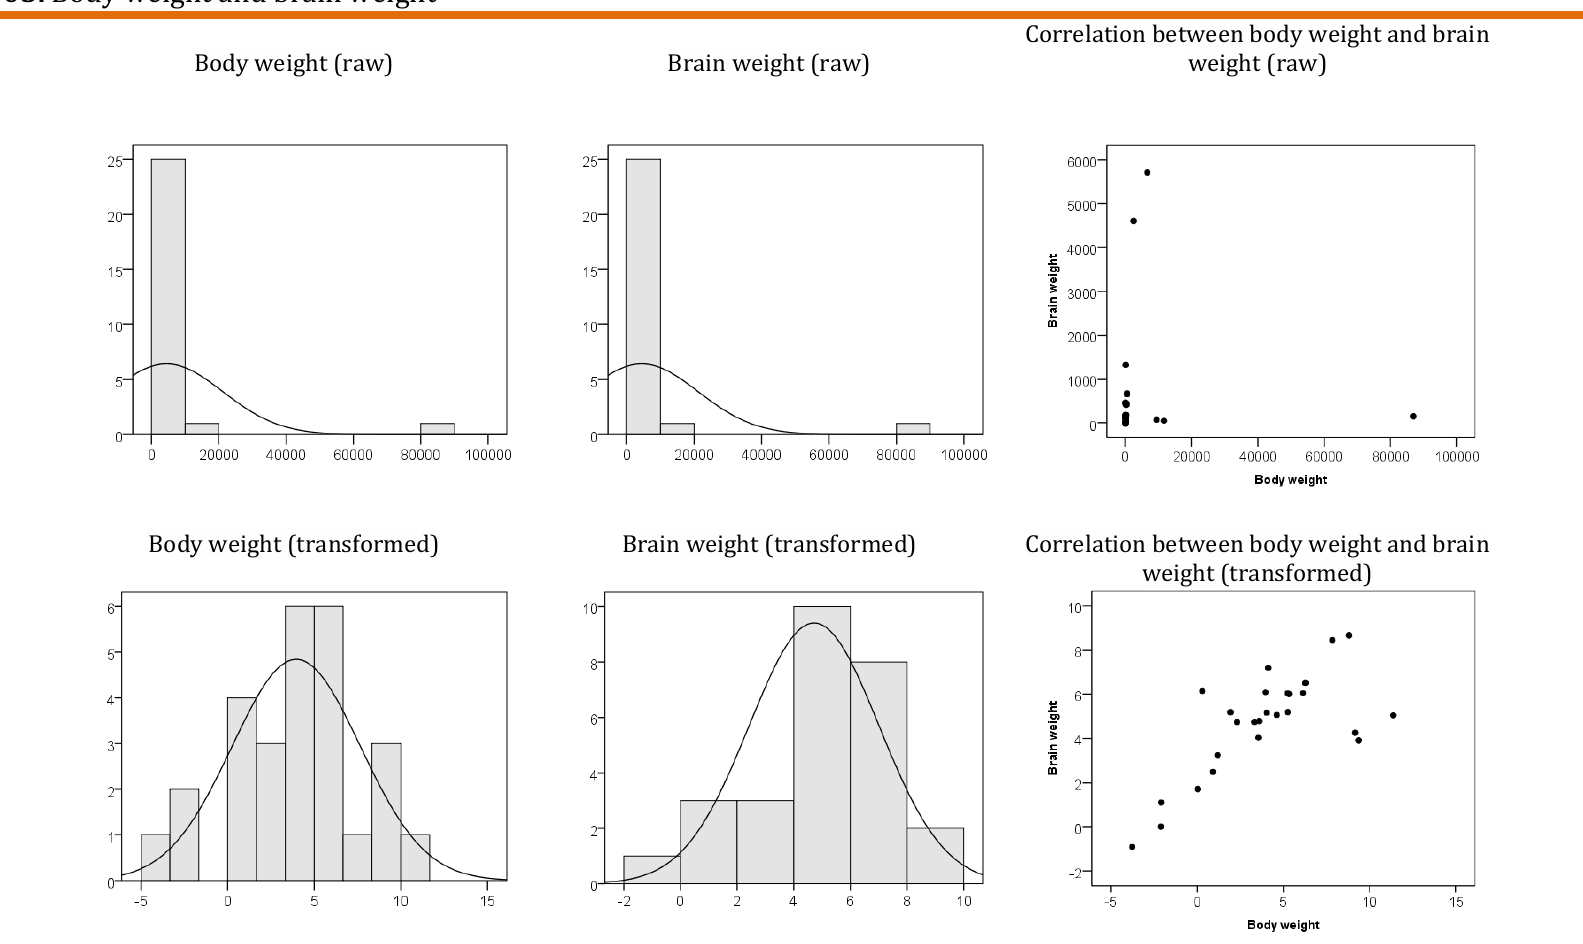
Figure 03. Body weight and brain weight Body weight (raw) Brain weight (raw)